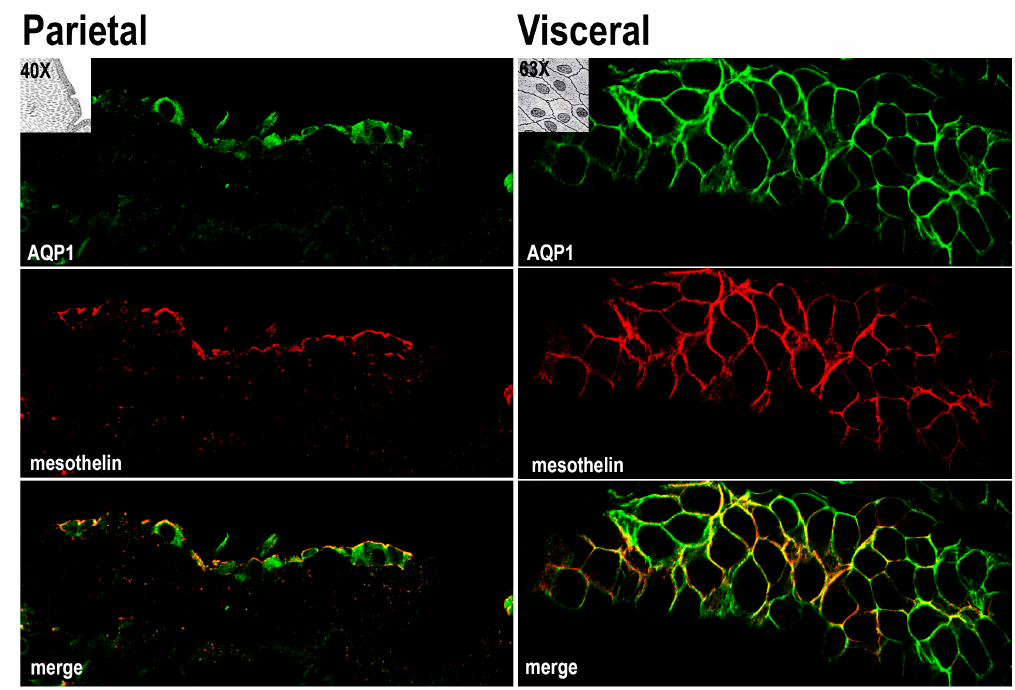
Figure 1. Samples of parietal and visceral (omentum) human peritoneum were analyzed by immunofluorescence with antibodies against AQP1 (green) and the surface marker of mesothelial (mesothelin) (red). Micrographs depict a longitudinal section of parietal mesothelium and a transversal section of visceral mesothelium. Colocalization (yellow) is highlighted in the merge panel. Comparable results were obtained in samples from three patients.